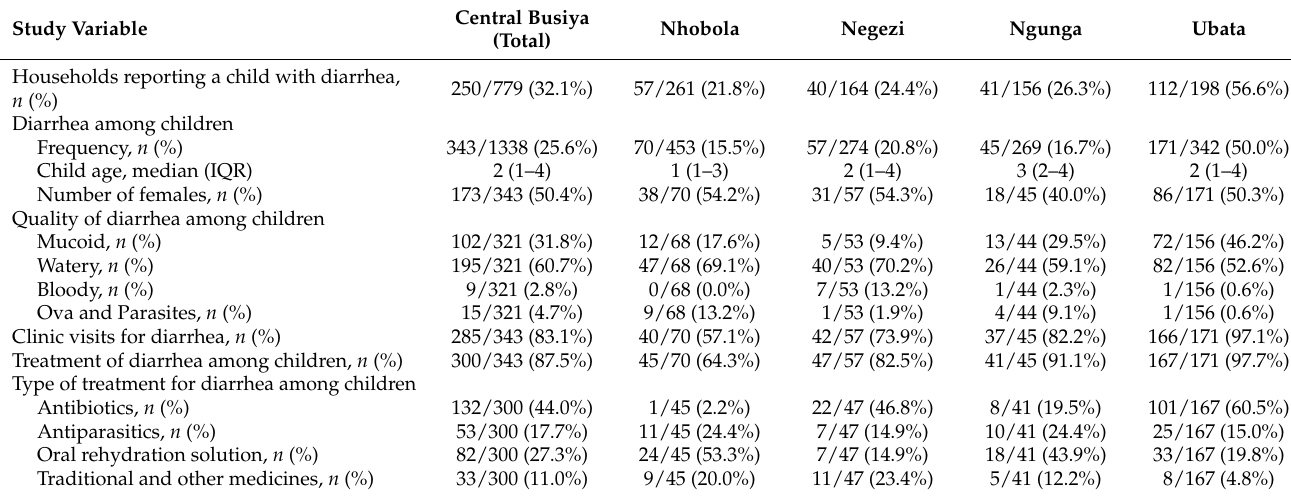
Table 2. Characteristics of under-five children with